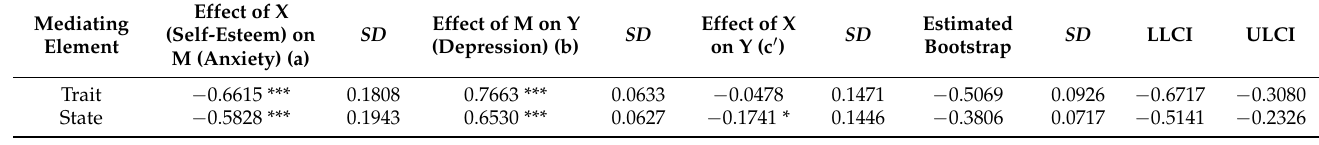
Table 8. Results of the mediation of self-esteem on depression through anxiety. * p < 0.05; *** p < 0.001. Mediating Element